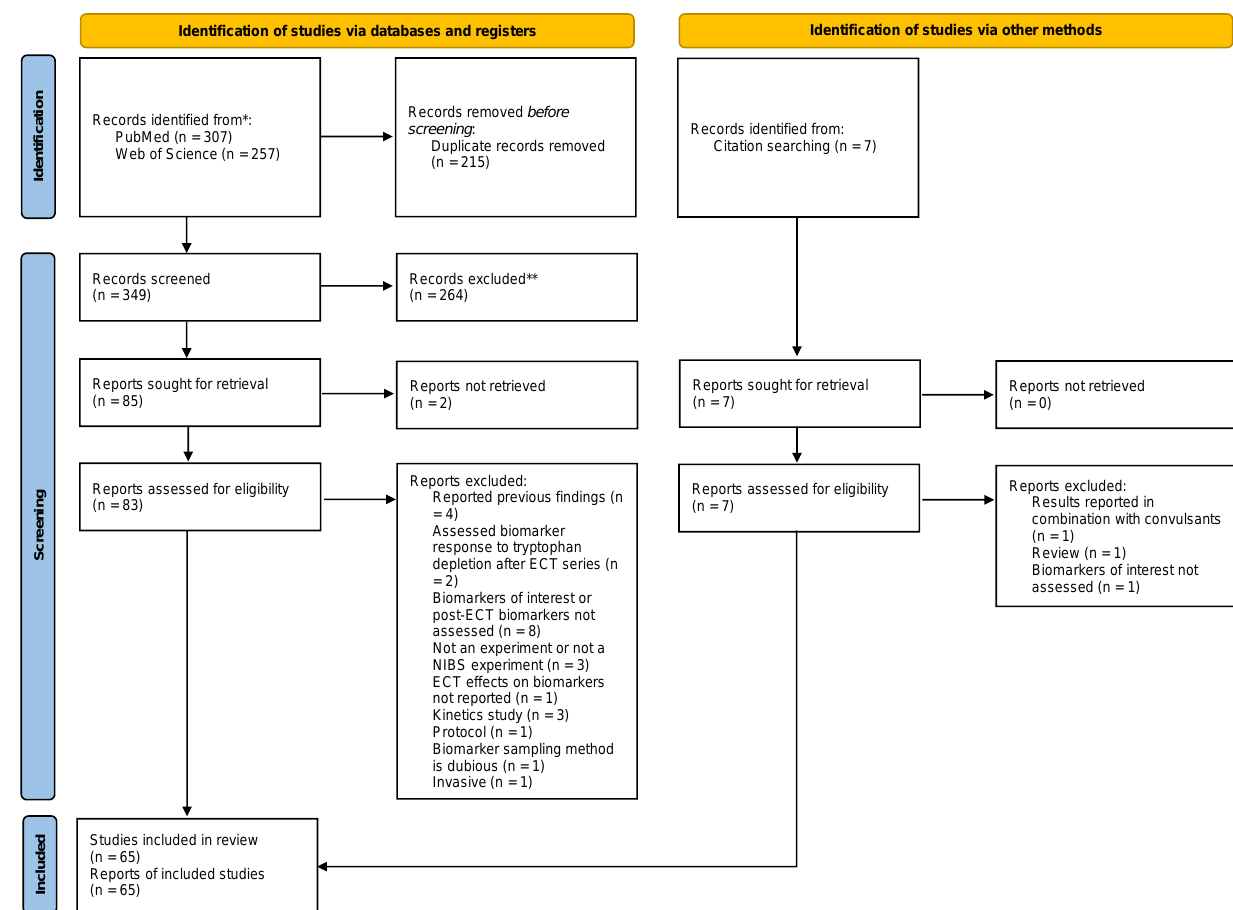
Figure 2. PRISMA flowchart. *: for each database in our search; **: no automation tools were used.